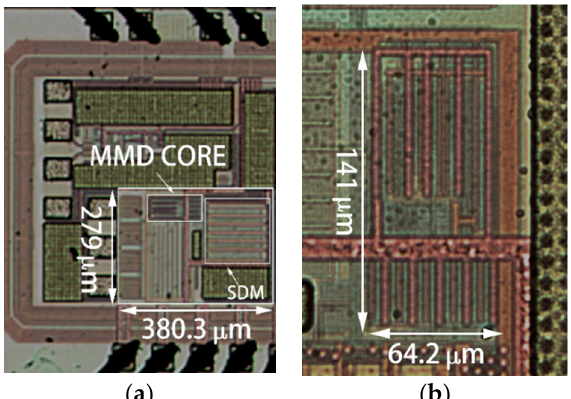
Figure 9. ( a ) Die micrograph of MMD, including Σ − ∆ modulator and MMD core; ( b ) Die micrograph of MMD core.